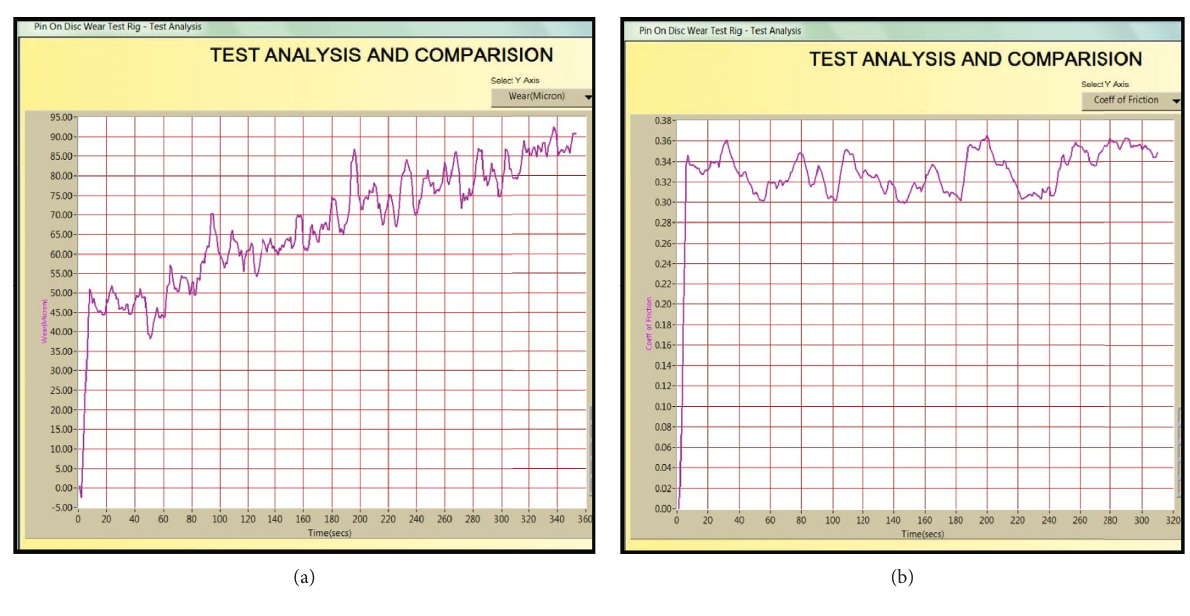
Figure 14: Wear test specimen-C.